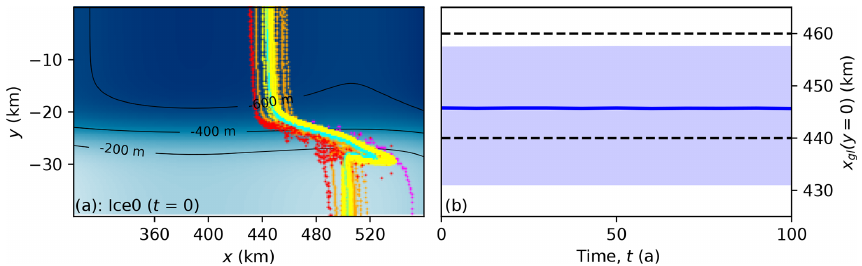
Figure 3. Grounding line contours for all models with (cid:49)x ≤ 1km at the start of the Ice0 experiments (a) and variation over 100 years (b) . In panel (a) , yellow contours correspond to SSA, L1Lx, and HO models with the Coulomb-limited basal friction laws; orange contours to SSA, L1Lx, and HO models with the Weertman basal friction law; red (ISSM) and cyan (Elmer/Ice) contours to full-Stokes models; and magenta contours to HySSA models. The color map and black contours depict bedrock elevation. In panel (b) , the bold line shows the grounding line position in the center of the channel, x gl (y = 0 ) , mean averaged over all models, and the shaded region depicts the maximum and minimum values. The dashed lines show the range specified in the experimental design, x gl (y = 0 ) = 450 ± 10km